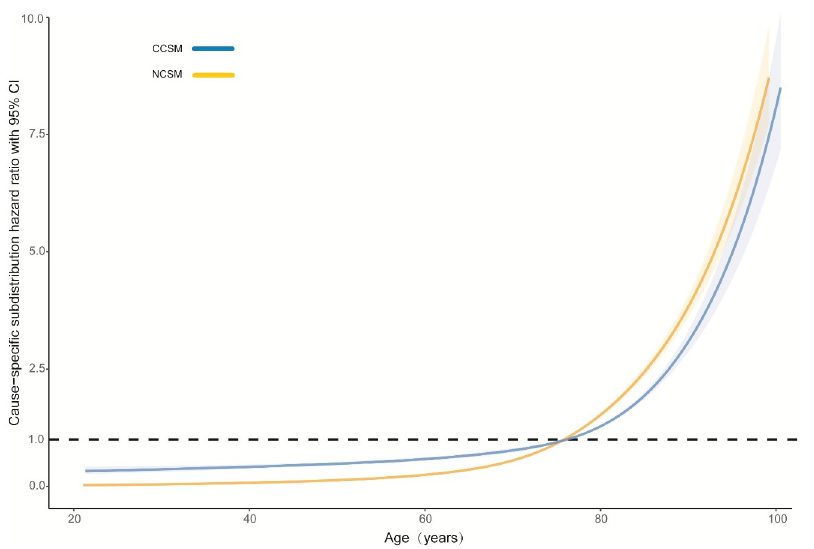
Fig 6. Age-varying association of cause-special mortality on age. CCSM: colon cancer-specific mortality; NCSM: noncancer-specific mortality.